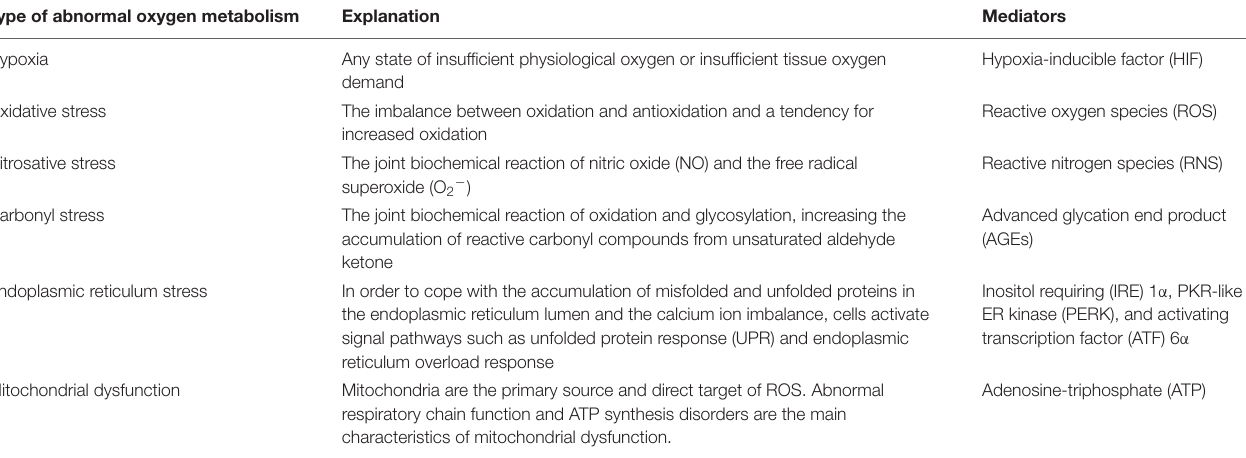
TABLE 2 | Comparison of different types of abnormal oxygen